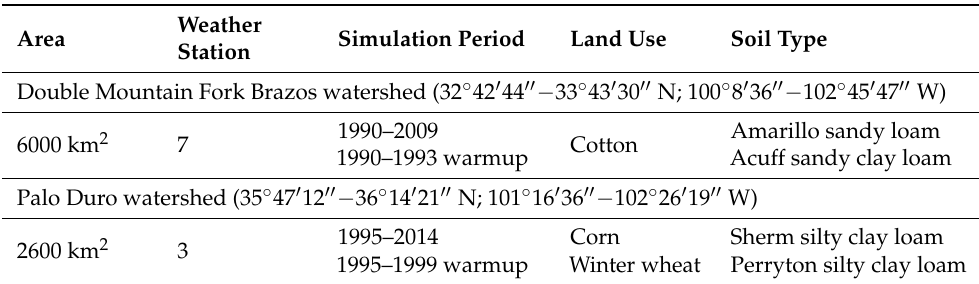
Table 1. Description of study watersheds in the Texas High Plains. Weather Simulation Period Land Use Soil Type Area Station